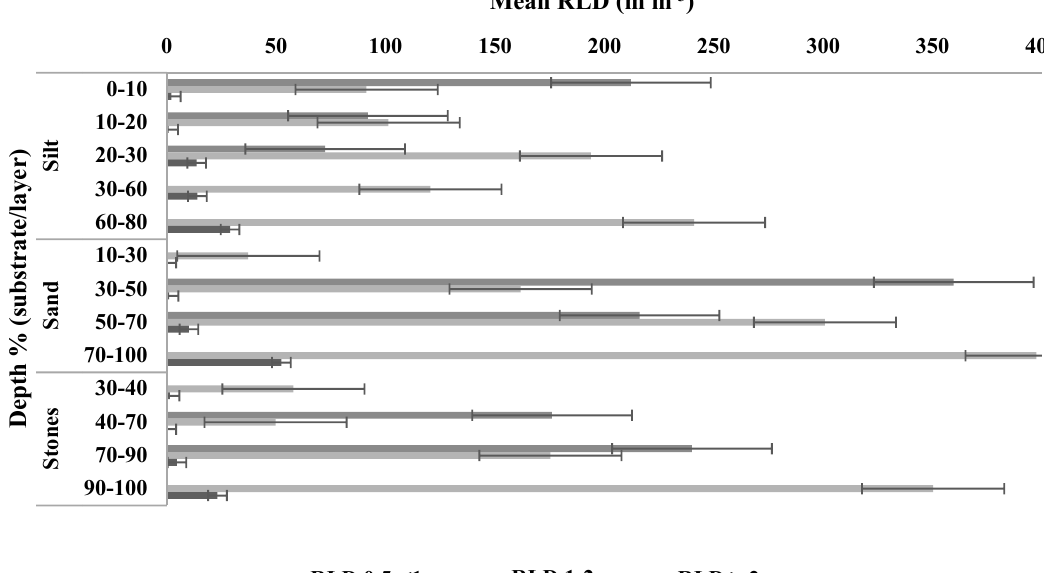
Figure 3. Variation in root length density (RLD) with depth in the three substrates. Error bars are 1 SE. Layers missing a value for the 0.5 < 1 mm root diameter were not sampled.